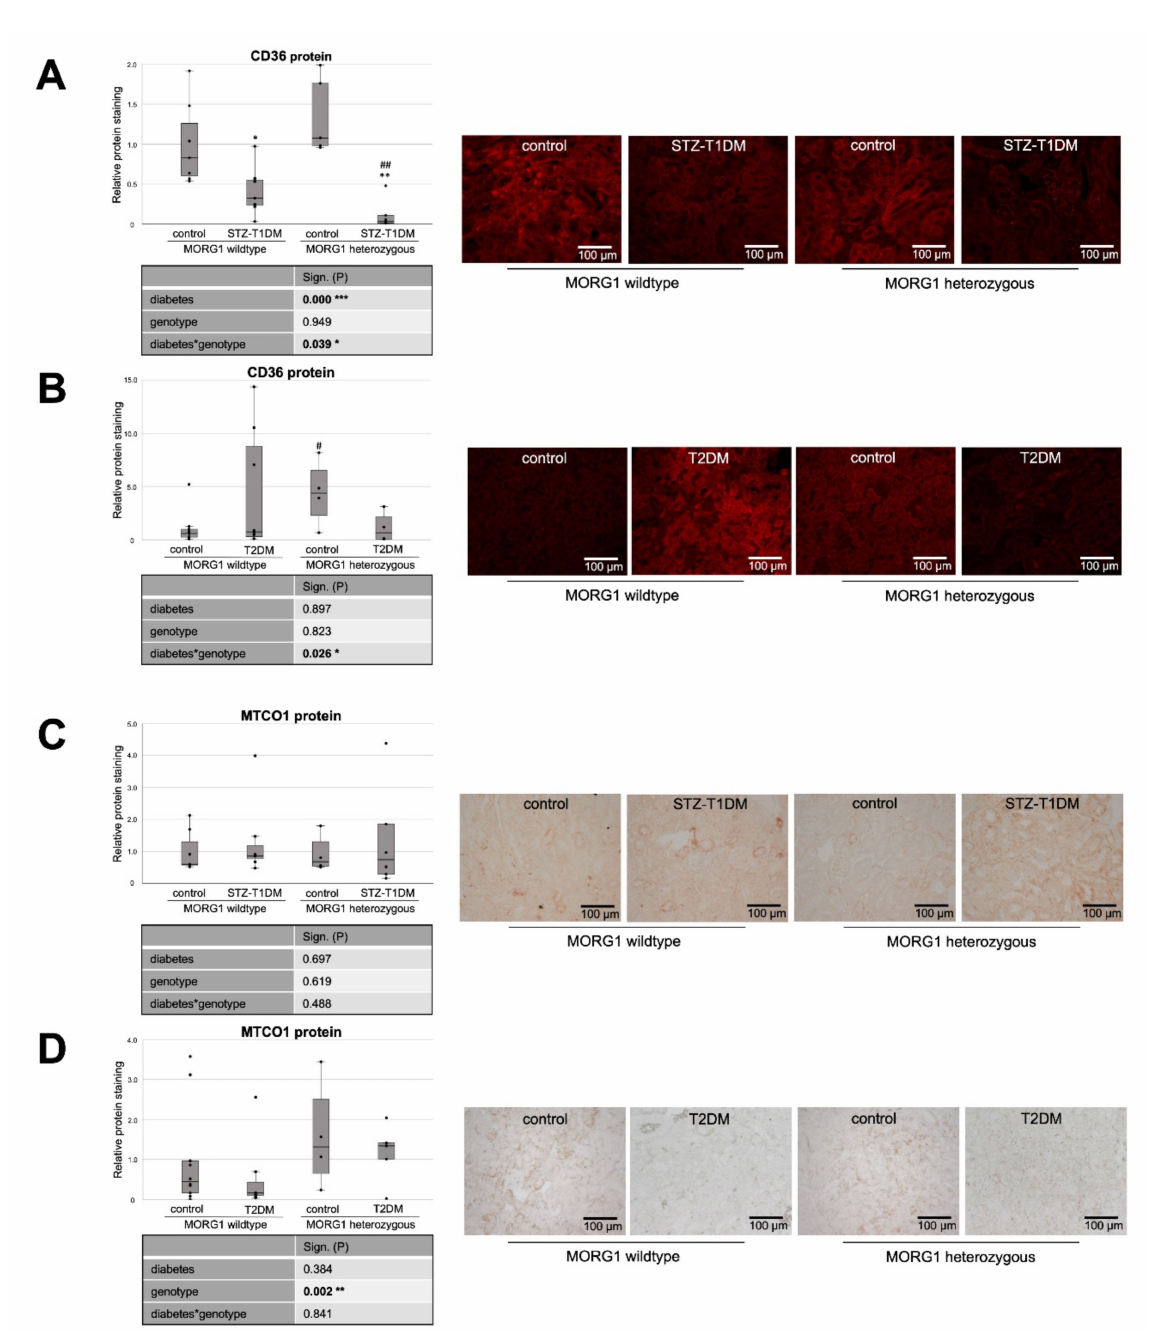
Figure 3. Analysis of fat uptake and metabolic stress in kidneys of diabetic animals. ( A , B ) Immunoflu- orescence staining of CD36 (cluster of differentiation 36) and semi-quantitative analysis of the staining in STZ-T1DM and T2DM. ( C , D ) Immunohistochemistry of MTCO1 (mitochondrially encoded cy- tochrome C oxidase 1) in STZ-T1DM and T2DM and semi-quantitative analysis of the staining. ( A – D ) Representative images are shown next to the graph (magnification × 200). The significances shown in the tables were assessed by two-way ANOVA with diabetes (control or STZ-T1DM/T2DM) and genotype (MORG1 wild-type or MORG1 heterozygous) as the two factors. Diabetes, genotype: main effect of diabetes/genotype, respectively. Diabetes*genotype: interaction. Bold: statistically significant. Significances shown next to each bar were assessed by using Mann–Whitney U test; * p ≤ 0.05 in between same genotype; ** p ≤ 0.01 in between same genotype; # p ≤ 0.05 in between different genotypes; ## p ≤ 0.01 in between different